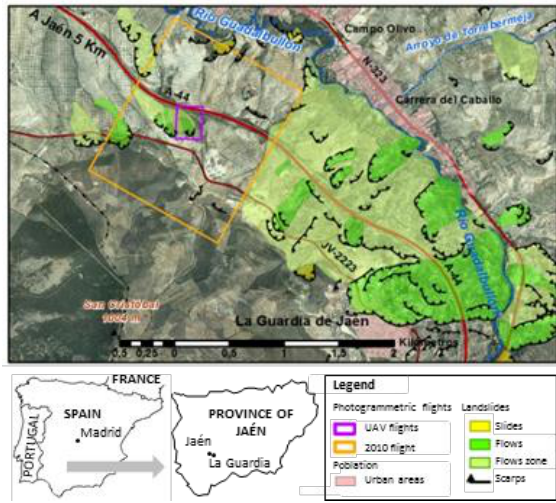
Figure 1. Area location and distribution of flights.